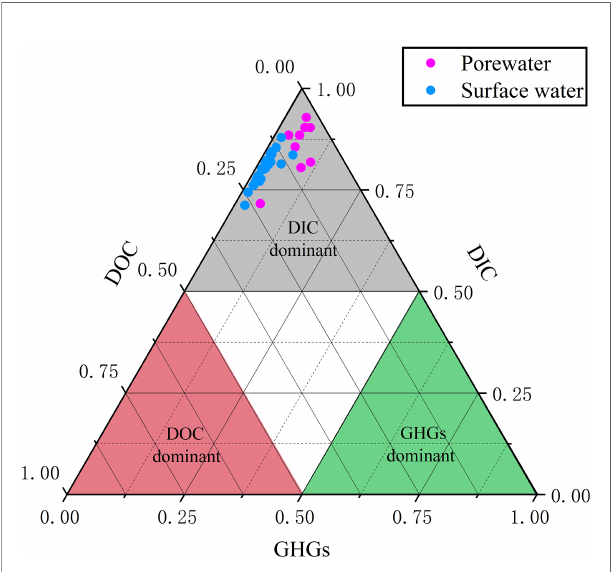
FIGURE 4 | Ternary diagram illustrating the percentage of different carbon species [DIC, DOC and greenhouse gases (GHGs)] in surface water and